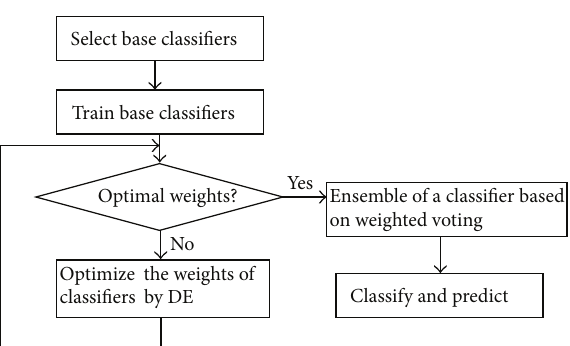
base classifiers to learn, including C4.5, Naive Bayes, Bayes Nets, 𝑘 -nearest neighbor ( 𝑘 -NN), and